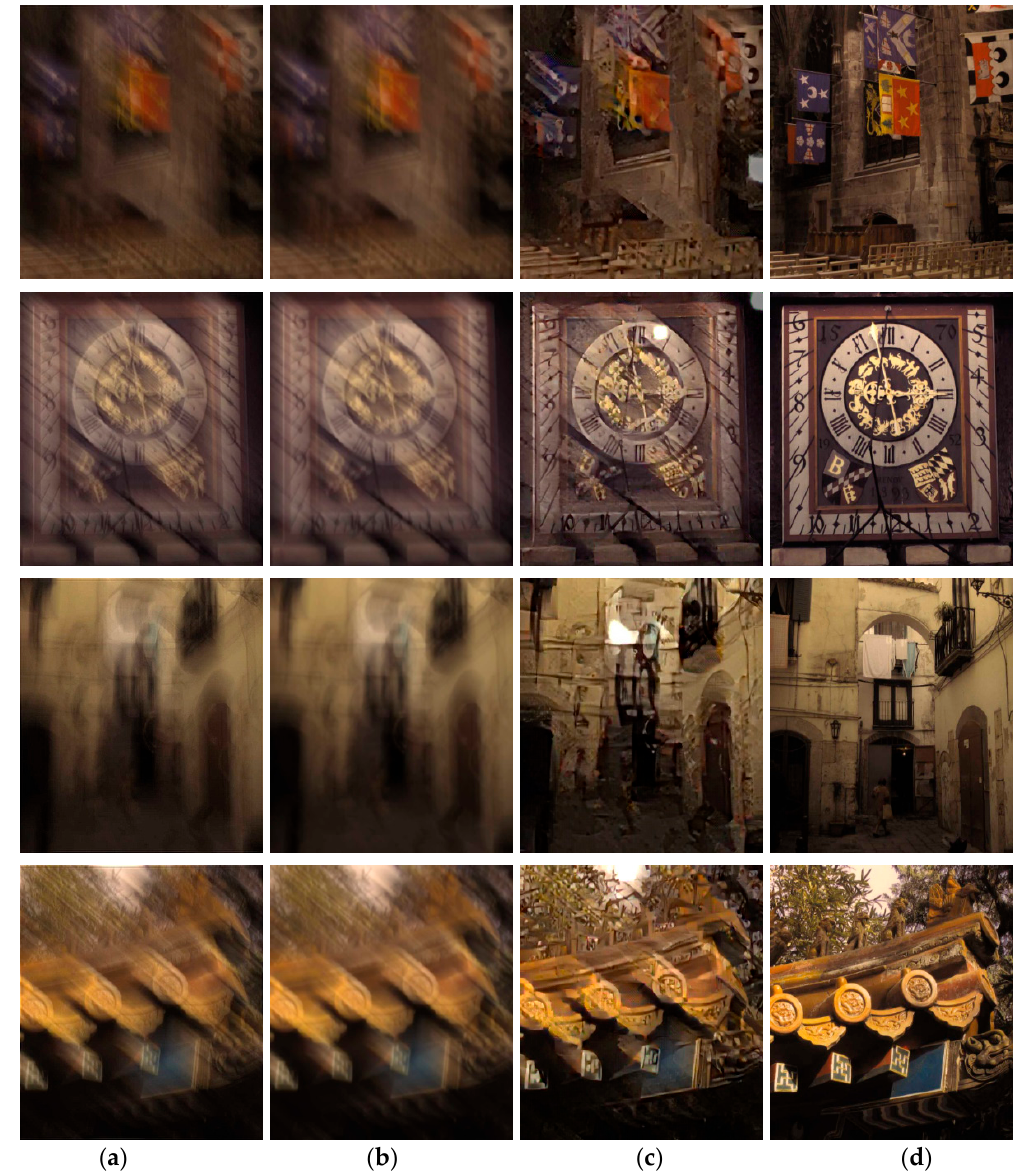
Figure 18. Output images from comparing proposed method with filter-based methods on Kohler dataset: ( a ) Wiener filter ( b ) Bilateral filter ( c ) Proposed method ( d ) Original sharp image.